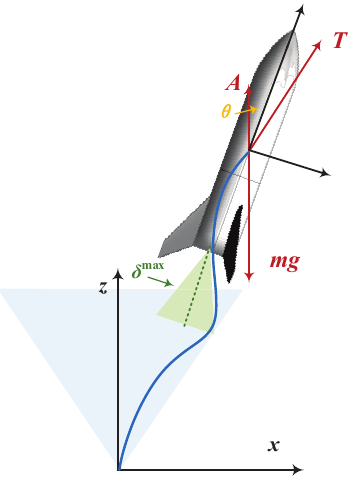
Figure 1. Planar landing model considering pitch attitude